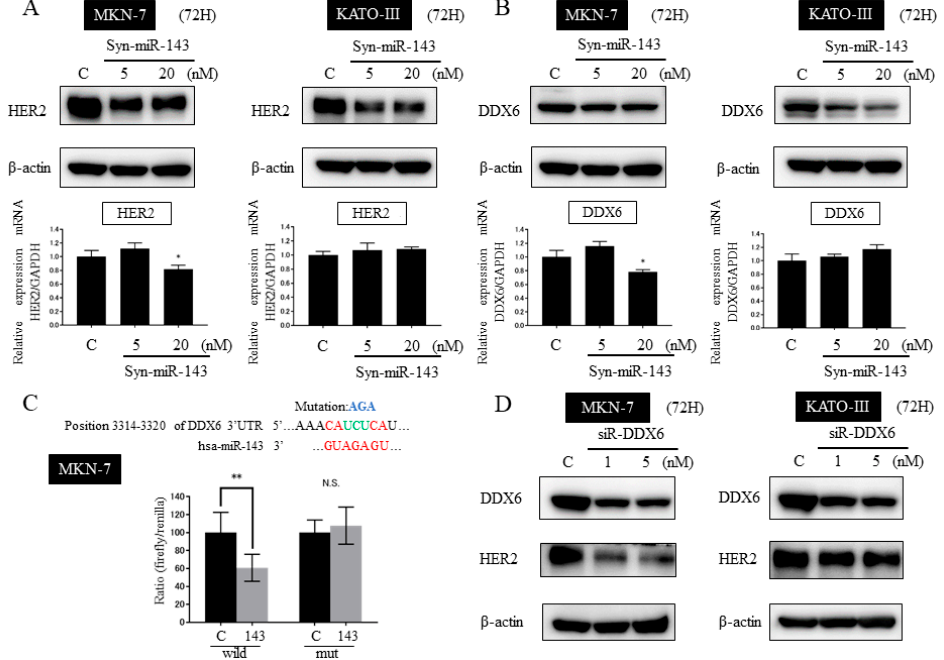
Figure 4. Relationship between HER2 and DEAD/H-box RNA helicase 6 (DDX6) expression after transfection with syn-miR-143. ( A ) Western blot analysis and qRT-PCR of HER2 at 72 h after transfection of MKN-7 and KATO-III cells with control RNA (20 nM) or syn-miR-143 (5 nM, 20 nM). ( B ) Western blot analysis and qRT-PCR of DDX6 at 72 h after transfection of MKN-7 or KATO-III cells with control RNA (20 nM) or syn-miR-143 (5 nM, 20 nM). ( C ) Relative luciferase activities of wild-type and mutant binding site on DDX for miR-143 in MKN-7 cells. ( D ) Expression levels of DDX6 and HER2 at 72 h after transfection of MKN-7 or KATO-III cells with control RNA (5 nM) or siR-DDX6 (1 nM, 5 nM). Results are presented with the mean ± SD; * p < 0.05, ** p < 0.01; N.S., not statistically significant.